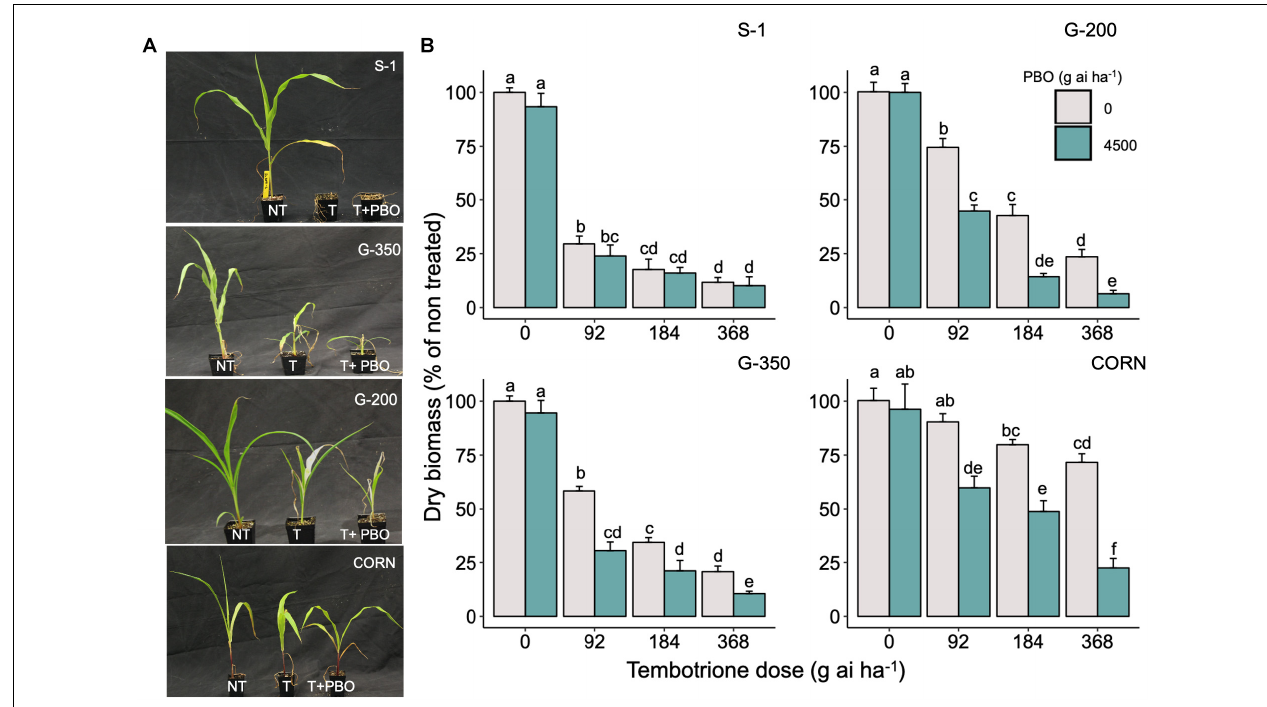
FIGURE 4 | (A) The response of S-1 (susceptible), G-200, G-350 (resistant), and corn to field recommended dose of tembotrione (92 g ai ha − 1 ) (T) or piperonyl butoxide (PBO) treatment (M1: 4,500 g ai ha − 1 ) followed by field recommended dose tembotrione. NT: non-treated. (B) Above-ground dry biomass of sorghum genotypes when pre-treated with PBO or different doses of tembotrione. The error bars represent the standard error ( n = 8); different alphabets indicate a significant difference between treatments ( p ≤